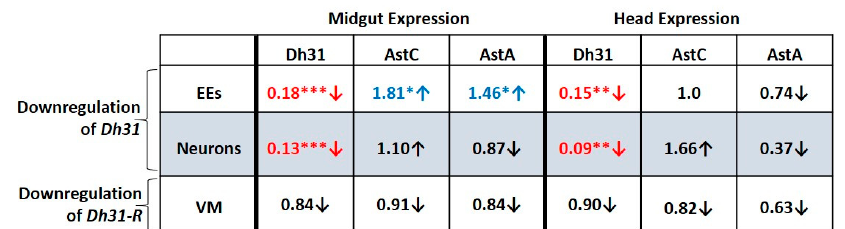
Figure 9. Downregulation of Dh31 in EEs or neurons reduces Dh31 expression in both the midgut and the head, while downregulation of Dh31 in EEs increases AstC and AstA expression in the mid ‐ gut. Relative expression levels of hormone ‐ encoding genes Dh31 , AstA and AstC in the midgut and the head upon EE ‐ specific (via prosV1 ‐ Gal4 ‐ UAS ‐ RNAi) or pan ‐ neuron ‐ specific (via elav ‐ Gal4 ‐ UAS ‐ RNAi) downregulation of Dh31 or VM ‐ specific (via 24B ‐ Gal4 ‐ UAS ‐ RNAi) downregulation of Dh31 ‐ R , normalized to flies prepared from Gal4 lines crossed to w 1118 . Values indicated in red and blue represent statistically significant decrease (red arrow pointing down) and increase (blue arrow pointing up) respectively, of the relative hormone gene expression. Each number represents the av ‐ erage of 12 values. Statistical analysis was performed using the t ‐ test. Statistical significance indi ‐ cated as * p < 0.05, ** p < 0.01 or *** p < 0.001.